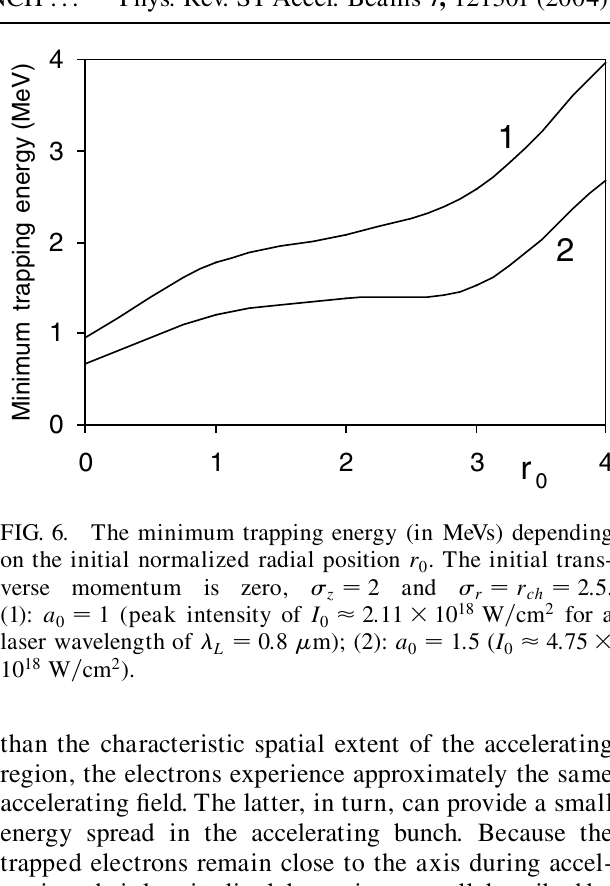
. The initial trans- 0 (cid:2) 2 and (cid:31) (cid:2) r (cid:2) 2 : 5 . z r ch (cid:14) 2 : 11 (cid:9) 10 18 W = cm 2 for a 0 (cid:2) 0 : 8 (cid:1) m ); (2): a (cid:2) 1 : 5 ( I (cid:14) 4 : 75 (cid:9) L 0 0